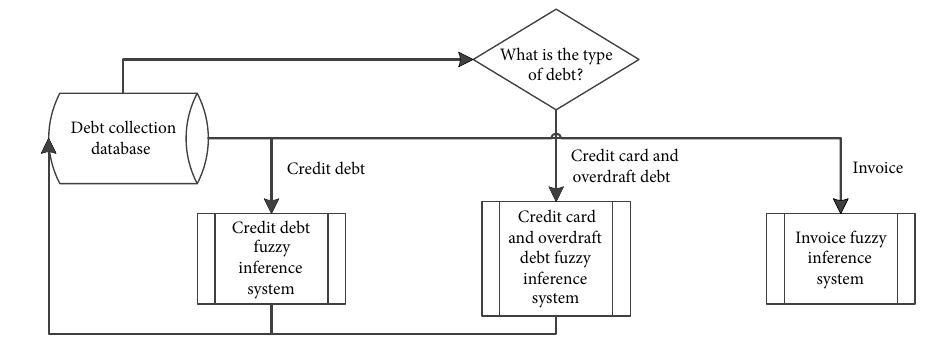
Figure 2. Early debt collection